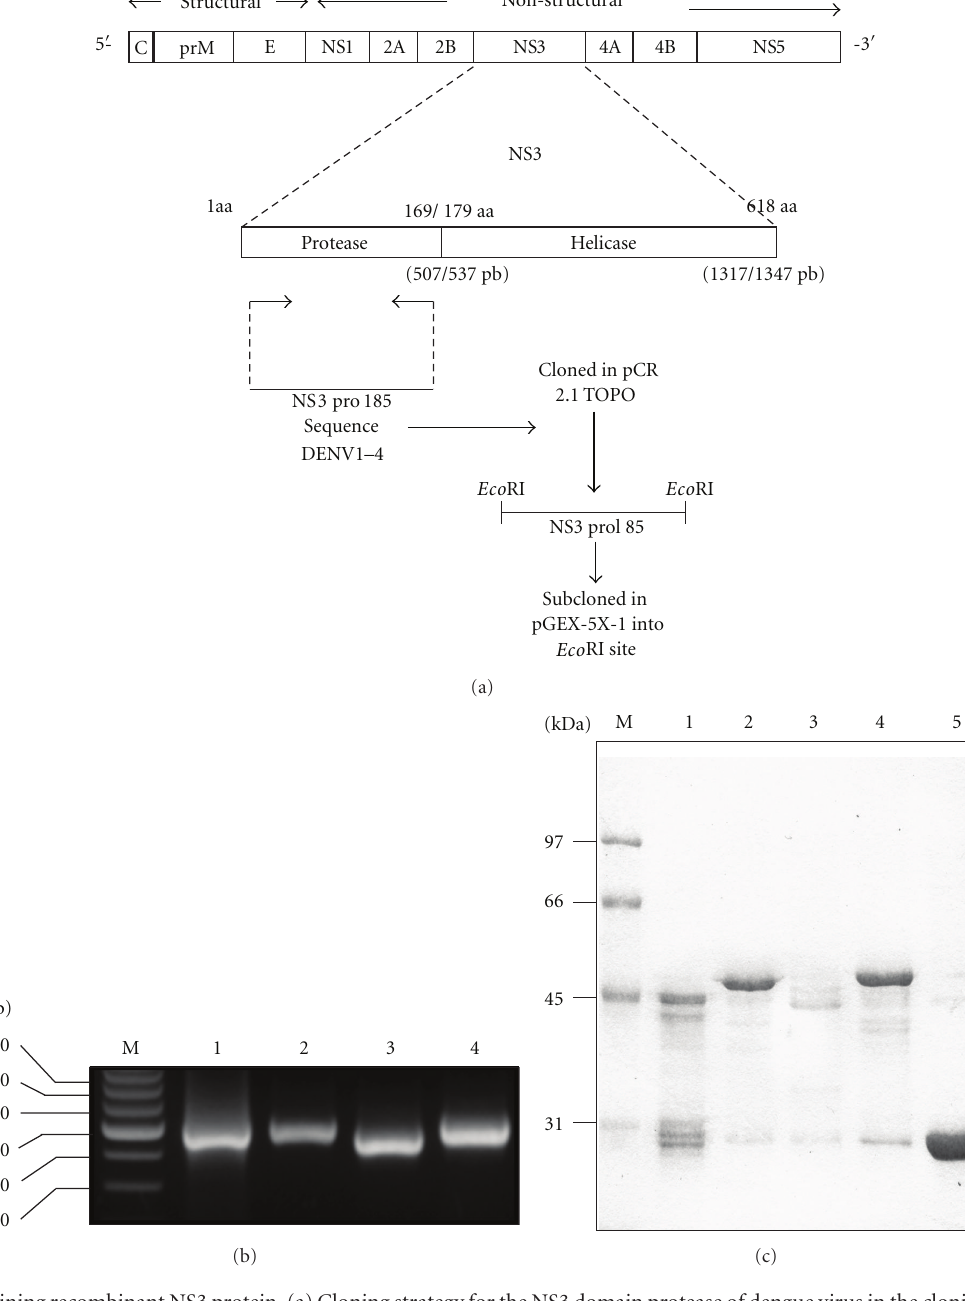
Figure 1: Obtaining recombinant NS3 protein. (a) Cloning strategy for the NS3 domain protease of dengue virus in the cloning vector and in prokaryotic expression vector. (b) Amplification of the NS3 protease gene cloned into pCR2.1TOPO, (M) size marker, Lane 1, NS3-DEN1. Lane 2, NS3-DEN2. Lane 3, NS3-DEN3. Lane 4, NS3-DEN4. (c) Purification of the recombinant protein GSTNS3 of each serotype.